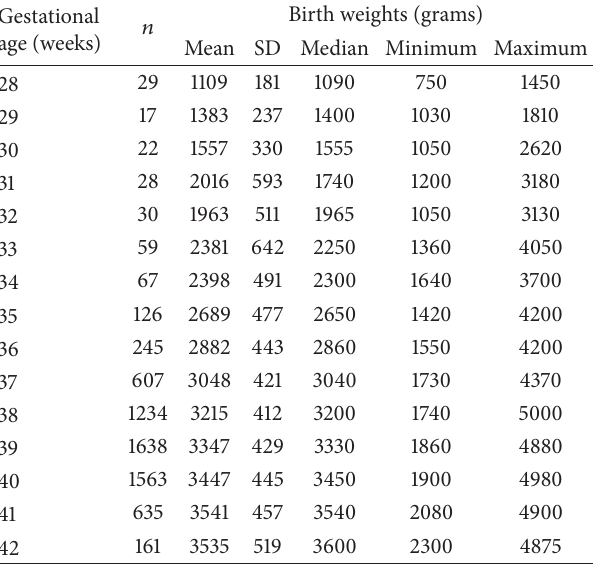
Table 1: Distribution of crude birth weights for gestational age for male Cameroonian